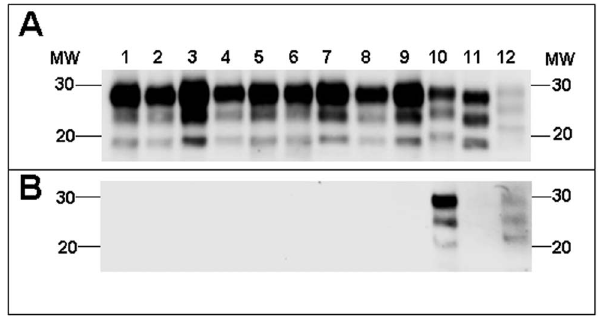
Figure 4. PrP res in BoPrP-Tg110 mice. Electrophoretic profiles and antibody labelling of PrP res as detected by mAbs Sha31 (A) and 12B2 (B) in brain extracts from BoPrP-Tg110 mice inoculated with the different BSE-derived prions: cattle-BSE (lane 1), sheep-BSE (lane 2), OvTg-BSE (lane 3), pig-BSE (lane 4), PoTg-BSE (lane 5), mouse-BSE (lane 6), MoTga20-BSE (lane 7), human-vCJD (lane 8), HuTg-BSE (lane 9). Brain extracts from BoPrP-Tg110 mice inoculated with atypical cattle-BSE H (lane 10), sheep-scrapie (lane 11) and mouse-RML (lane 12) were included as a control non-BSE related prion propagated in the same mouse model. Panels A and B were loaded with the same quantities of PrP res extracted from each sample. MW, molecular weight in kilodaltons.